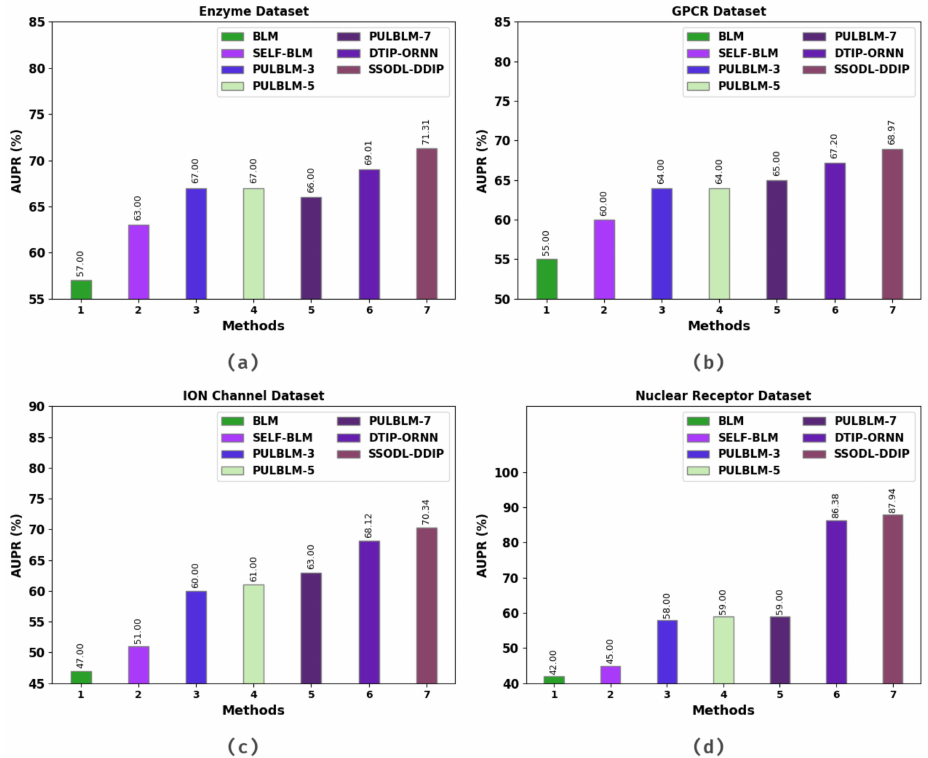
Figure 8. AUPR analysis of the SSODL-DDIP technique: ( a ) Enzyme; ( b ) GPCR; ( c ) ion channel; ( d ) nuclear